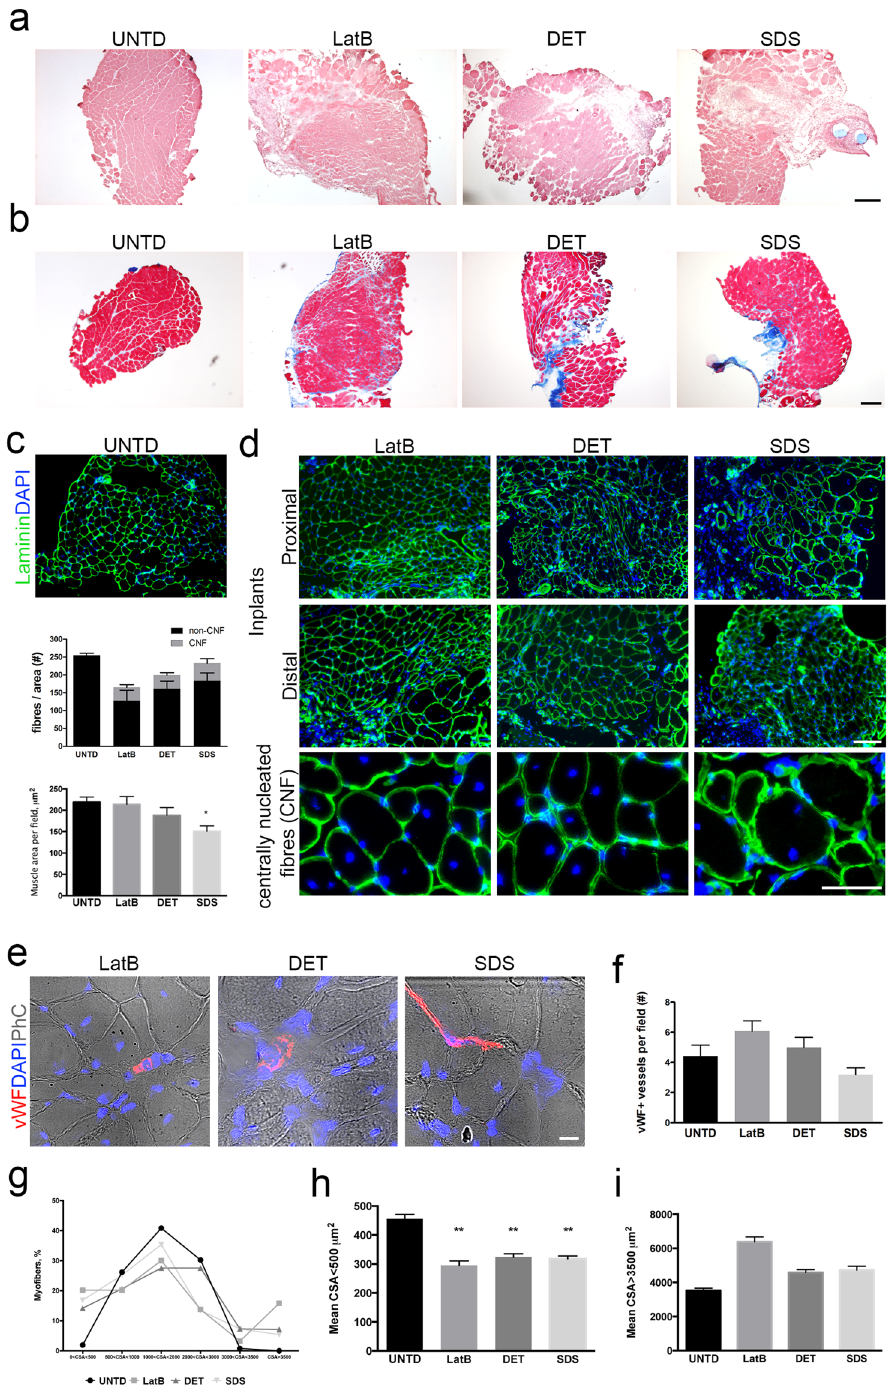
Figure 5. Decellularised skeletal muscles induce muscle regeneration in a mouse model of VML. ( a ) H&E staining of cross-sections from contralateral untreated EDL (UNTD) and the middle region of LatB-, DET- and SDS-implanted scaffolds two months after implantation. Scale bar: 250 µ m. ( b ) Masson’s Trichrome staining of cross-sections from UNTD muscles and the middle region of LatB-, DET- and SDS-implanted scaffolds two months after implantation. Scale bar: 250 µ m. H&E staining of cross-sections from UNTD muscles and LatB-, DET- and SDS-implanted scaffolds two months after implantation. Cross-sections showed centrally nucleated fibres, connective tissue and myofibres of variable size into the implanted scaffold. Scale bar, 50 µ m. ( c ) Representative images of immunofluorescence analysis for laminin (green) in cross-sections from contralateral untreated EDL muscles, and ( d ) LatB-, DET- and SDS-implanted scaffolds, two months after implantation. Nuclei were stained with dapi (blue). Scale bar, 100 µ m. Bottom line: higher magnifications to show centrally nucleated fibres (CNF). Scale bar, 50 µ m. ( e ) Quantification of the number of fibres per field and respective contribution of CNF and non-CNF in UNTD muscles and implanted scaffolds, using images of